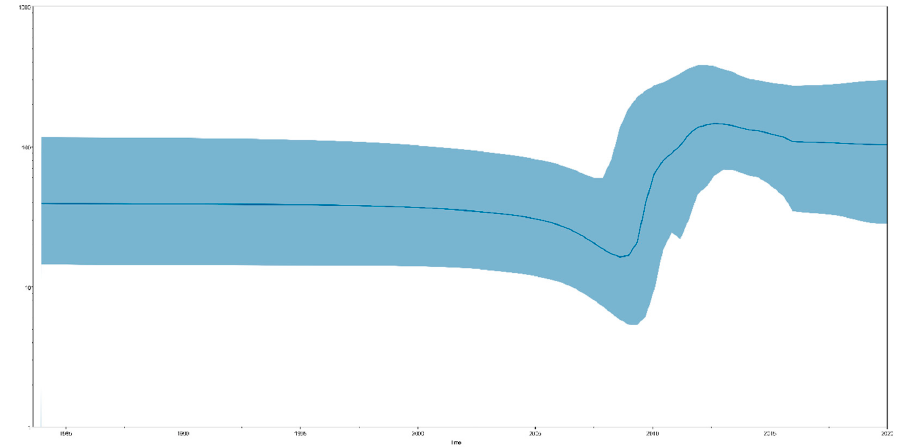
Figure 2. A Bayesian skyline plot exhibiting the effective population size change for the E gene of TMUV. A measure of group change is shown on the y -axis with 95% HPD